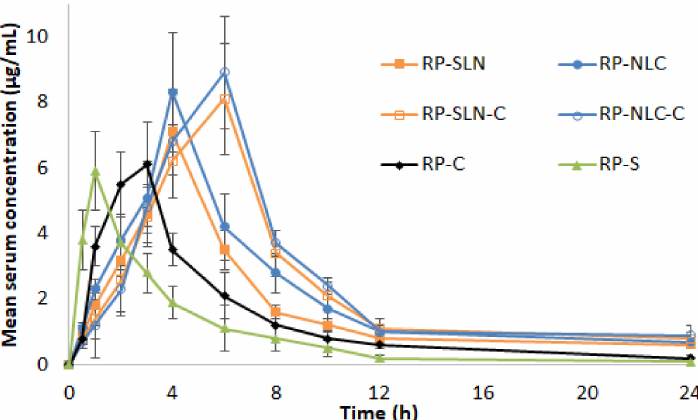
Figure 6. Mean serum and time profiles of RP from RP-SLN, RP-NLC, RP-S and RP-SLN-C, RP-NLC-C, RP-C formulations after oral and topical administration, respectively in Wistar rats (mean ± SD, n =